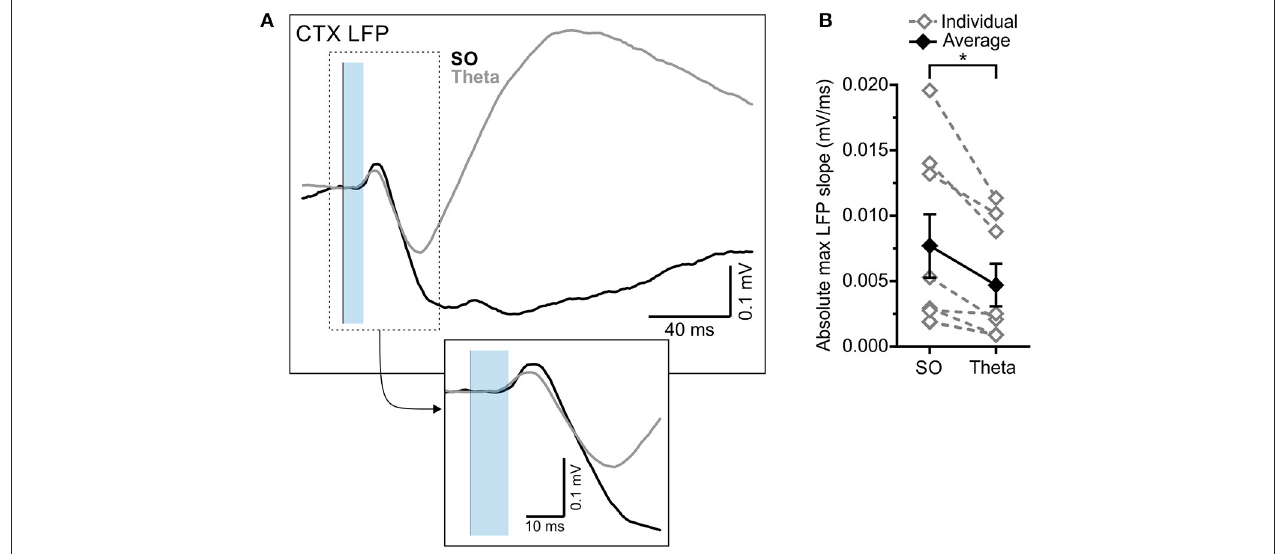
FIGURE 4 | RE-evoked cortical field potentials are modulated by state. (A) Cortical local field potential evoked by 10ms optogenetic stimulation of RE (blue transparent rectangle), averaged over 64 trials in both SO (black) and theta (gray) states. Inset: Magnified representation of the box in the main panel, highlighting the initial slope of the evoked response. (B) Absolute maximum slope of the initial cortical potential in (A) across both states, in individuals (gray, hollow diamonds, and dashed gray lines) and on average (black, filled diamonds, and solid black line). * p <